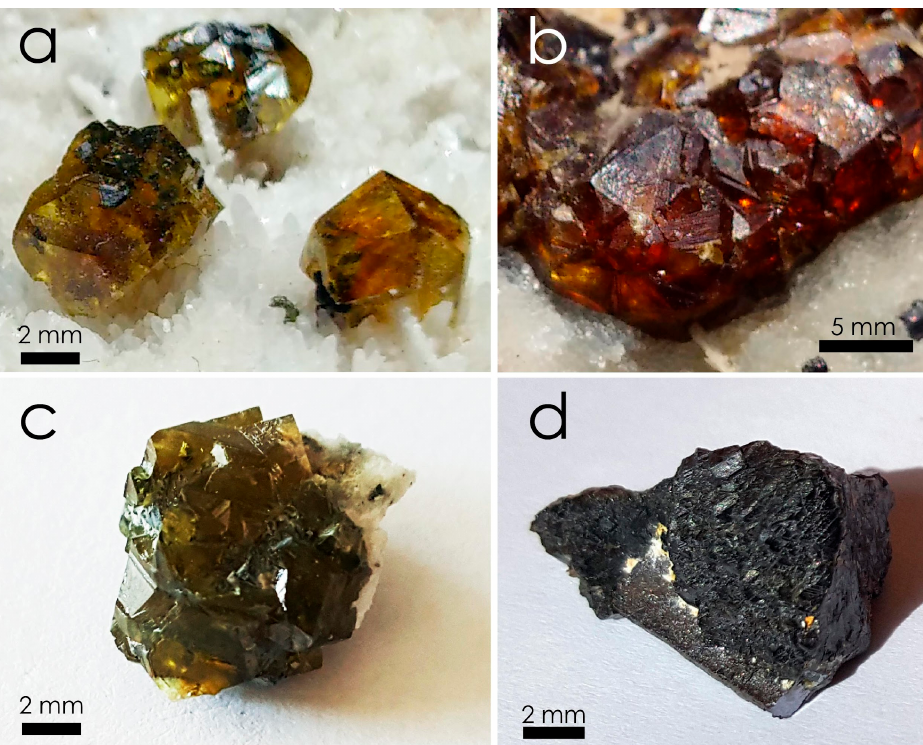
Figure 2. Studied samples of sphalerite: a ) yellow sphalerite from the Göllner mine on the Terézia vein in Štiavnické Bane near Banská Štiavnica (sample A); b ) orange sphalerite from the 12 th horizon of the Michal shaft, the Juraj field on the Terézia vein (sample B); c ) olive-green sphalerite from the Göllner mine on the Terézia vein in Štiavnické Bane near Banská Štiavnica (sample C); d ) black sphalerite from the Rozália mine in Hodruša-Hámre (sample D).